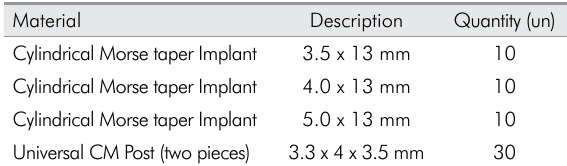
Table 1. Description of materials.